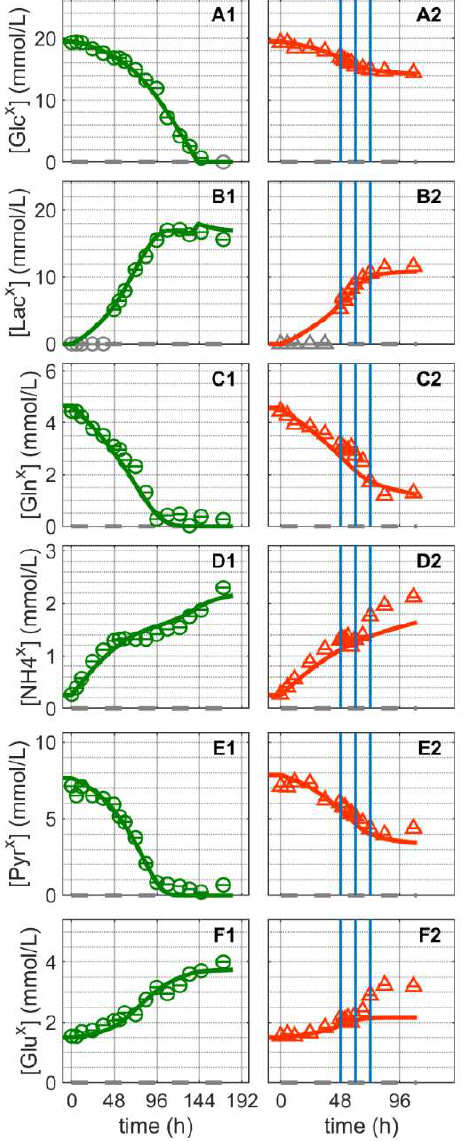
Figure 3. Dynamics of extracellular substrates and metabolic by-products in mock-infected and infected suspension MDCK cells. ( A1 , A2 ) Glucose, ( B1 , B2 ) lactate, ( C1 , C2 ) glutamine, ( D1 , D2 ) ammonium, ( E1 , E2 ) pyruvate, and ( F1 , F2 ) glutamate. Data and error bars represent the mean and standard deviation of technical triplicates for two independent experiments (mock-infected Θ and infected ∆). Lines: model simulations. Vertical blue lines correspond to 0, 12 and 24 h post infection, respectively. The grey dashed lines indicate the limit of quantification for each metabolite and grey data points are under the limit of quantification. Experimental data used for parameter estimation: A1 , B1 , C1 , D1 , E1 and F1 (see Supplementary Files S4 and S5).